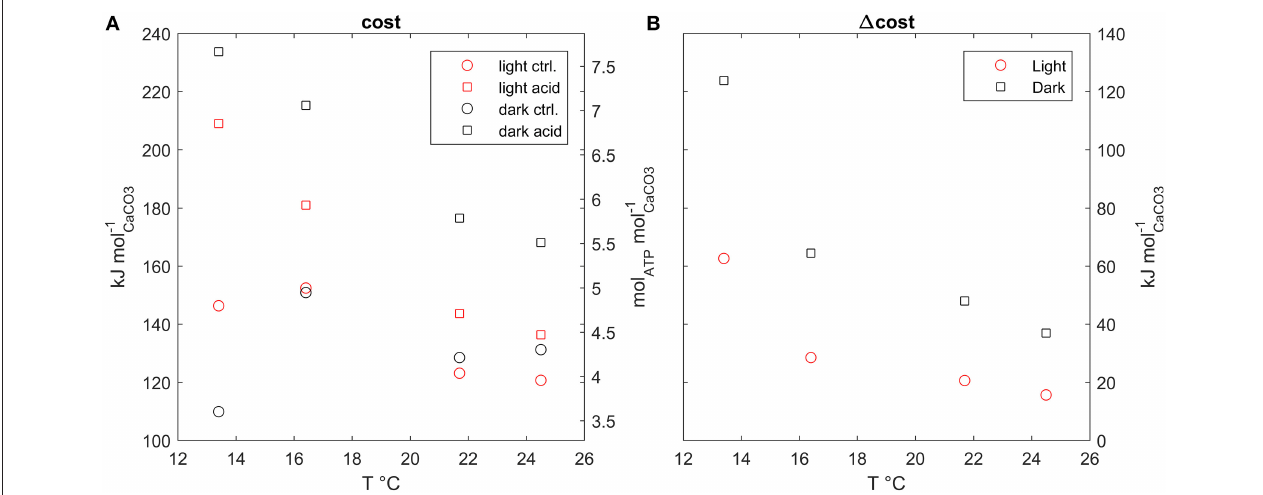
FIGURE 5 | (A) Calcification costs at all model setups plotted against temperature, (B) extra cost of calcification, difference between cost under acidified and control conditions, plotted against temperature.